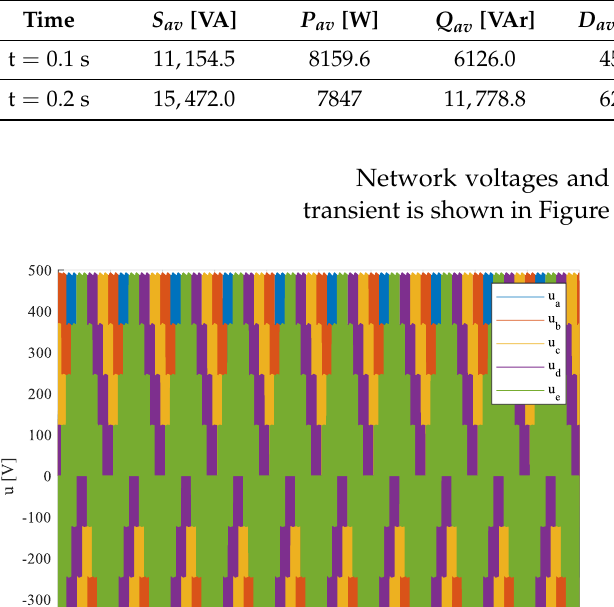
There is a considered system having two 1- phase inverters with PWM and supplying